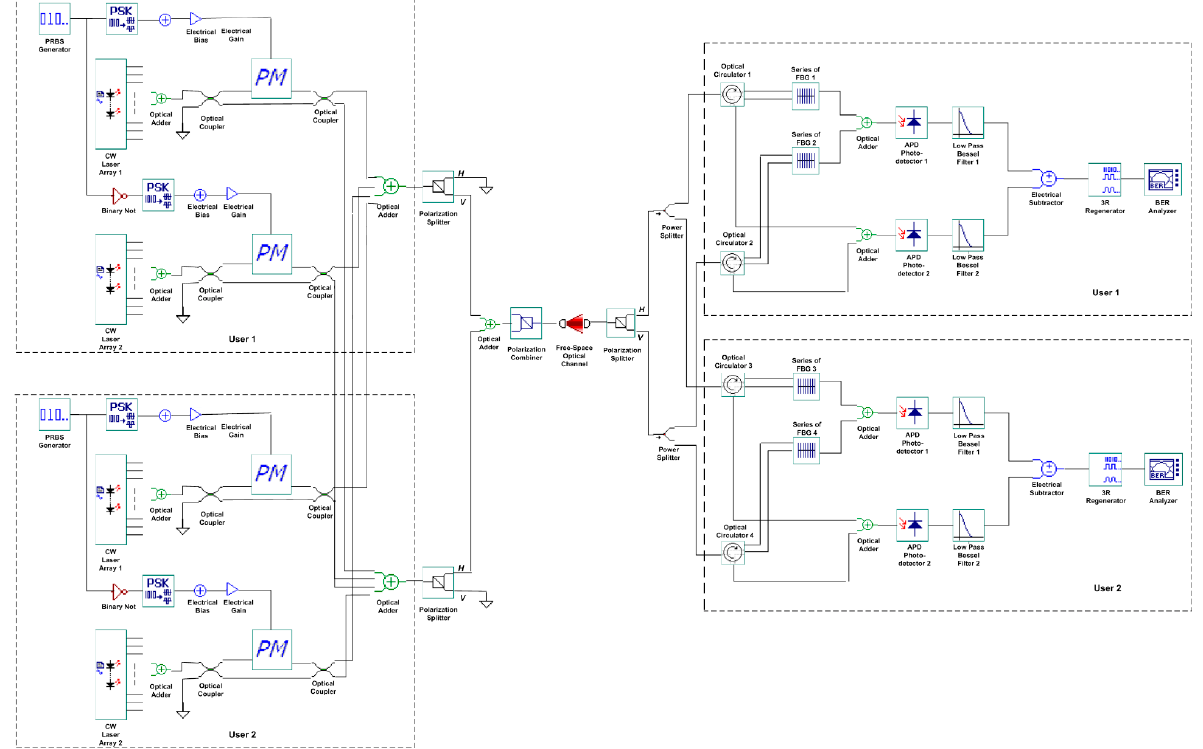
Figure 3. Proposed Bi ‐ OCDMA architecture for two users.